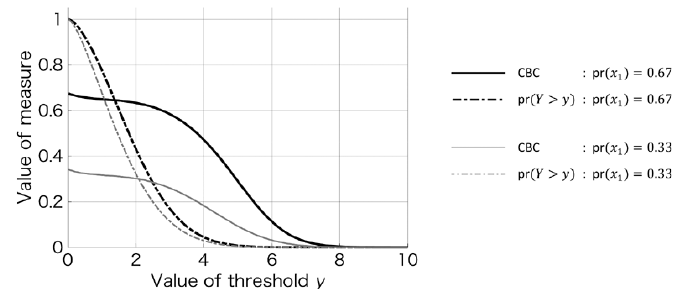
Figure 3: Comparison between the CBC and pr ( Y > y )